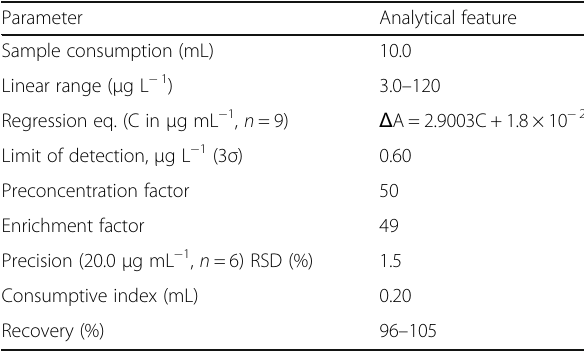
Table 4 Analytical characteristics of the DLLME-FAAS method for copper determination